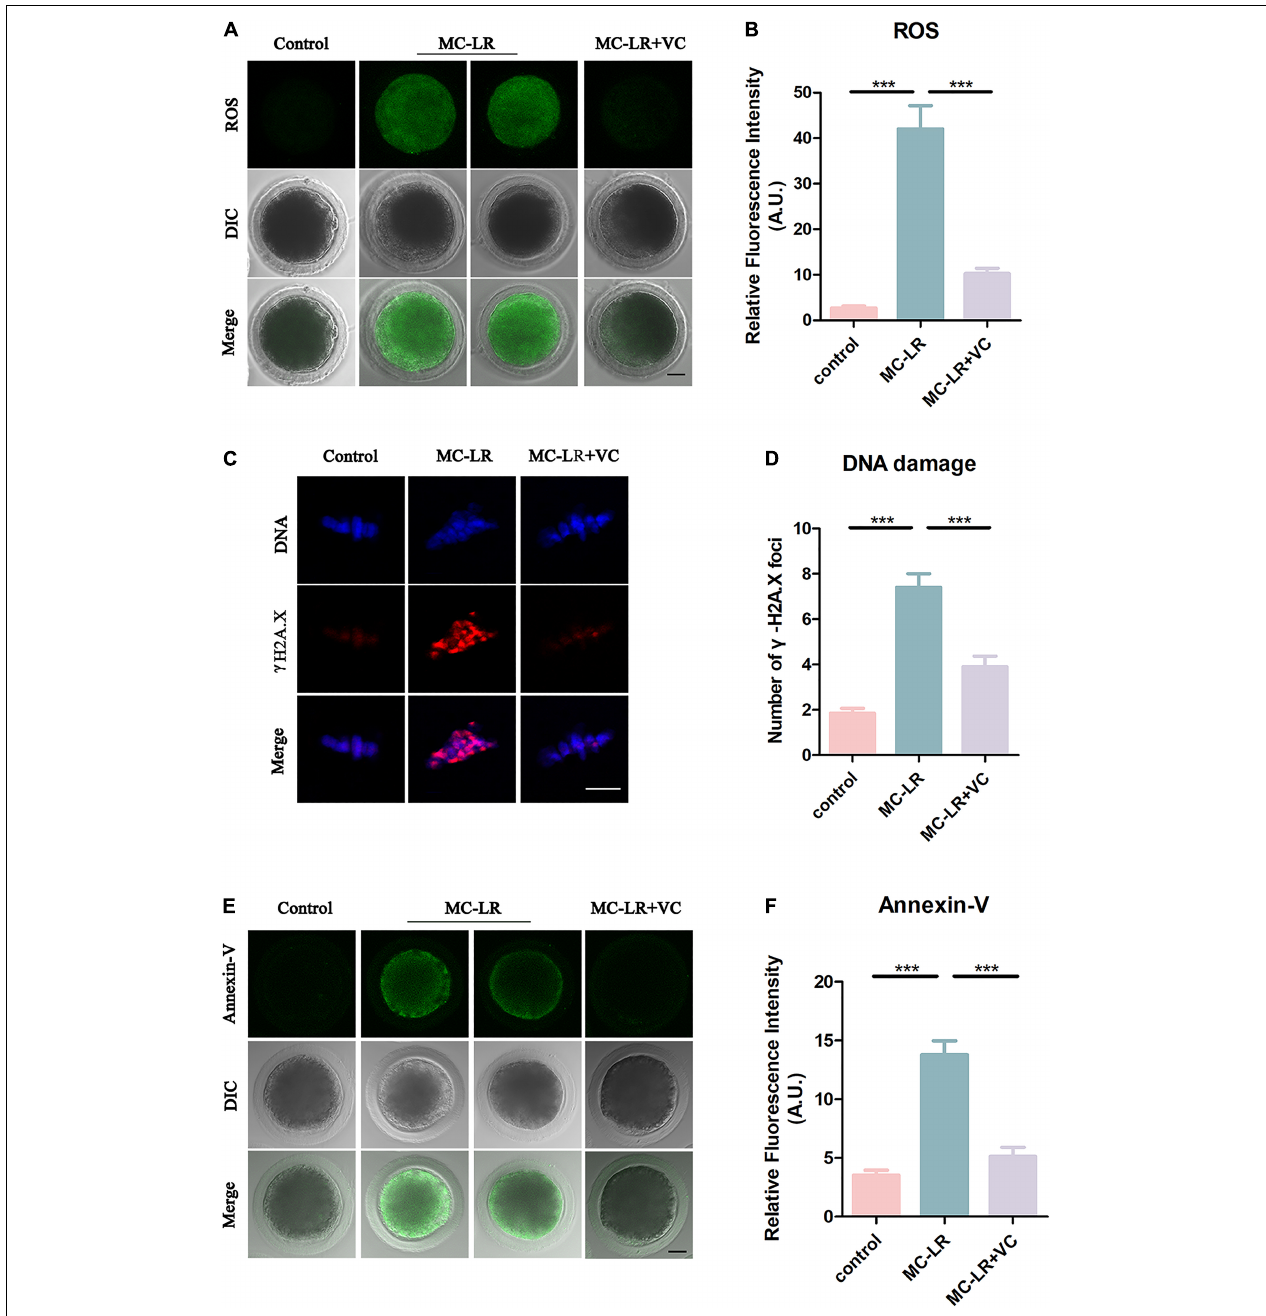
FIGURE 7 | VC decreases oxidative stress, alleviates DNA damage, and rescues early apoptosis in MC-LR-exposed oocytes. (A) Representative images of ROS level in the control, MC-LR-exposed, and VC-rescued groups. Bar = 20 µ m. (B) Quantitative analysis of the fluorescence intensity of ROS. (C) Immunofluorescent staining of γ -H2A.X showing DNA damage in control, MC-LR-exposed, and VC-rescued groups. Bar = 5 µ m. (D) Quantification of the numbers of γ -H2A.X foci per oocyte in control, MC-LR-exposed, and VC-rescued groups was analyzed (total number of oocytes analyzed: n = 20 for control; n = 20 for MC-LR-exposed, n = 20 for VC-rescued). Data are expressed as mean ± SEM from three independent experiments. (E) Representative images of apoptotic oocytes in the control, MC-LR-exposed, and VC-rescued groups. Bar = 20 µ m. (F) Quantitative analysis of the fluorescence intensity of Annexin-V. *** p < 0.001.